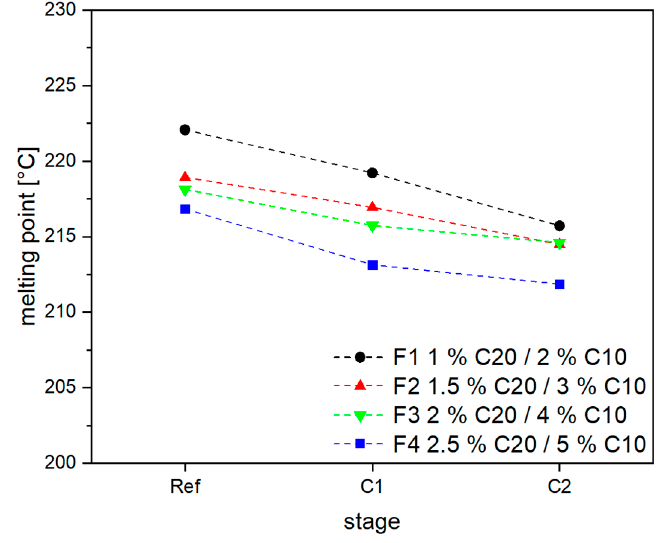
Figure 15. Melting points of the four formulations in different stages in °C measured with a DSC. Ricco reported a decrease of the melting temperature (Tm) with increasing residual monomer ◦ content. He states that T m is reduced by 3.5 to 5 C per wt % monomer [14,32]. Van Rijswijk obtains